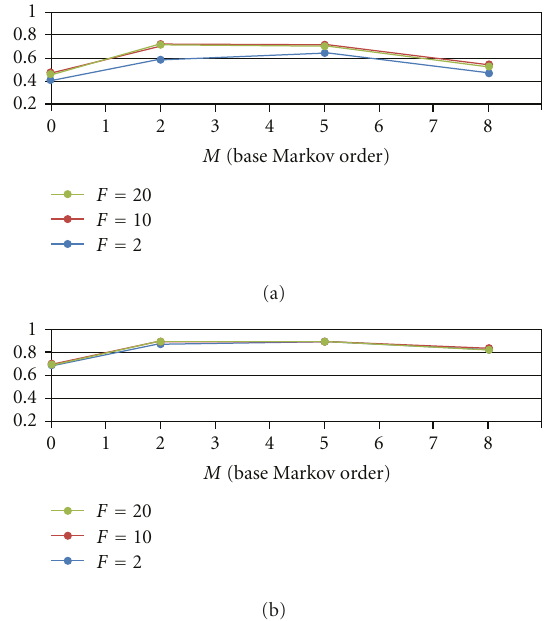
Figure 6: M-view. (a) Full-exon level accuracy for C. elegans 5-fold cross-validation. (b) Base level accuracy for C. elegans 5-fold cross-